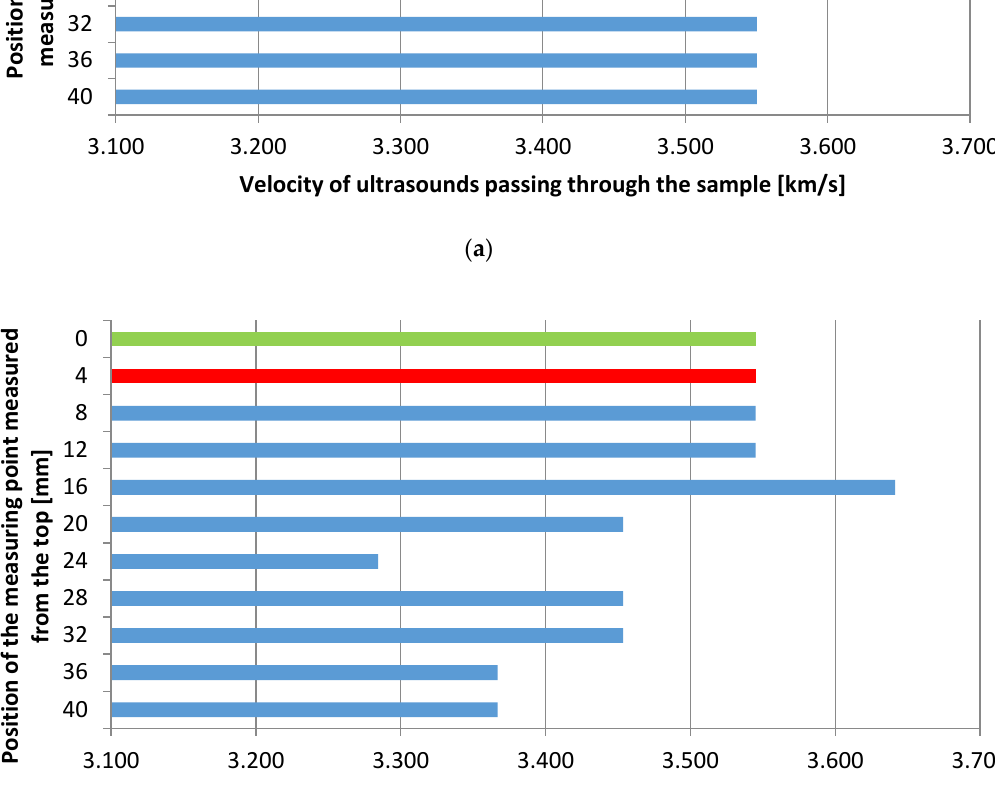
Figure 15. The dependence of the velocity of ultrasounds as a function of the sample’s height (green value—coating, red value—primer, blue value—substrate): ( a ) without the addition of fibers, ( b ) with the addition of 0.5 wt % of polypropylene fibers .